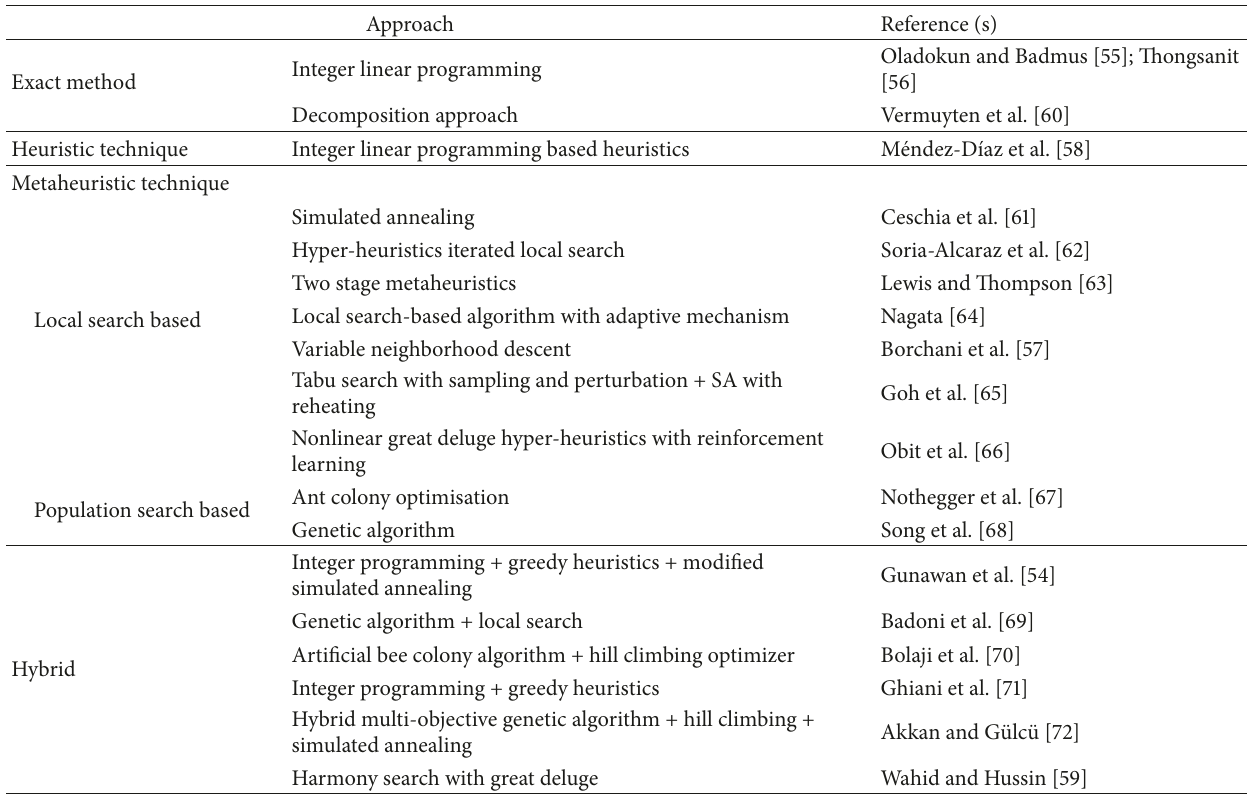
Table 6: Summary of studies related to CTP.